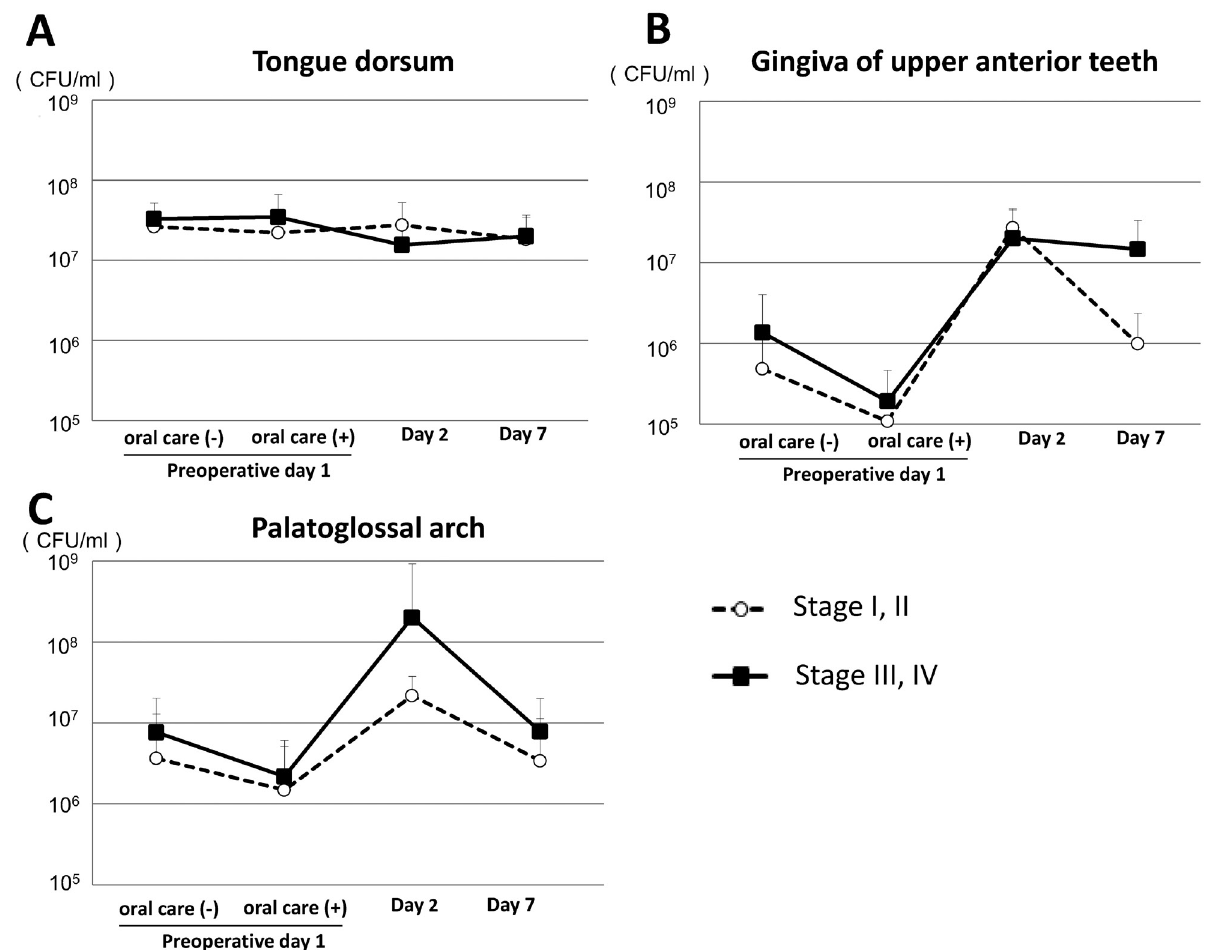
Figure 4- Comparison of oral bacterial counts between early and advanced tumor stage in open surgery group. (A) Numbers of oral bacteria on the dorsum of the tongue. Error bars represent mean±SD; (B) Numbers of oral bacteria on the gingiva of upper anterior teeth; (C) Numbers of oral bacteria on the palatoglossal